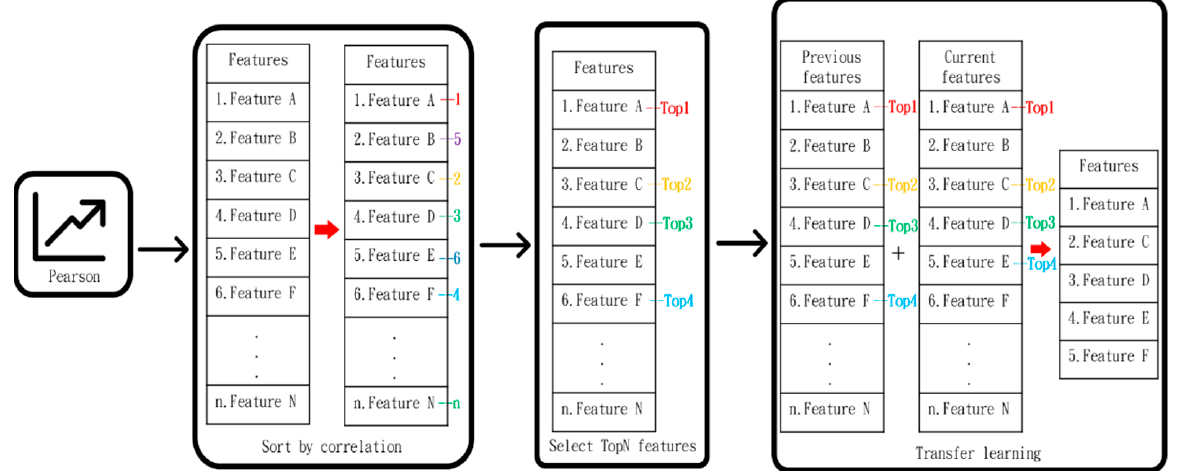
Figure 3. Example illustrating the proposed method.